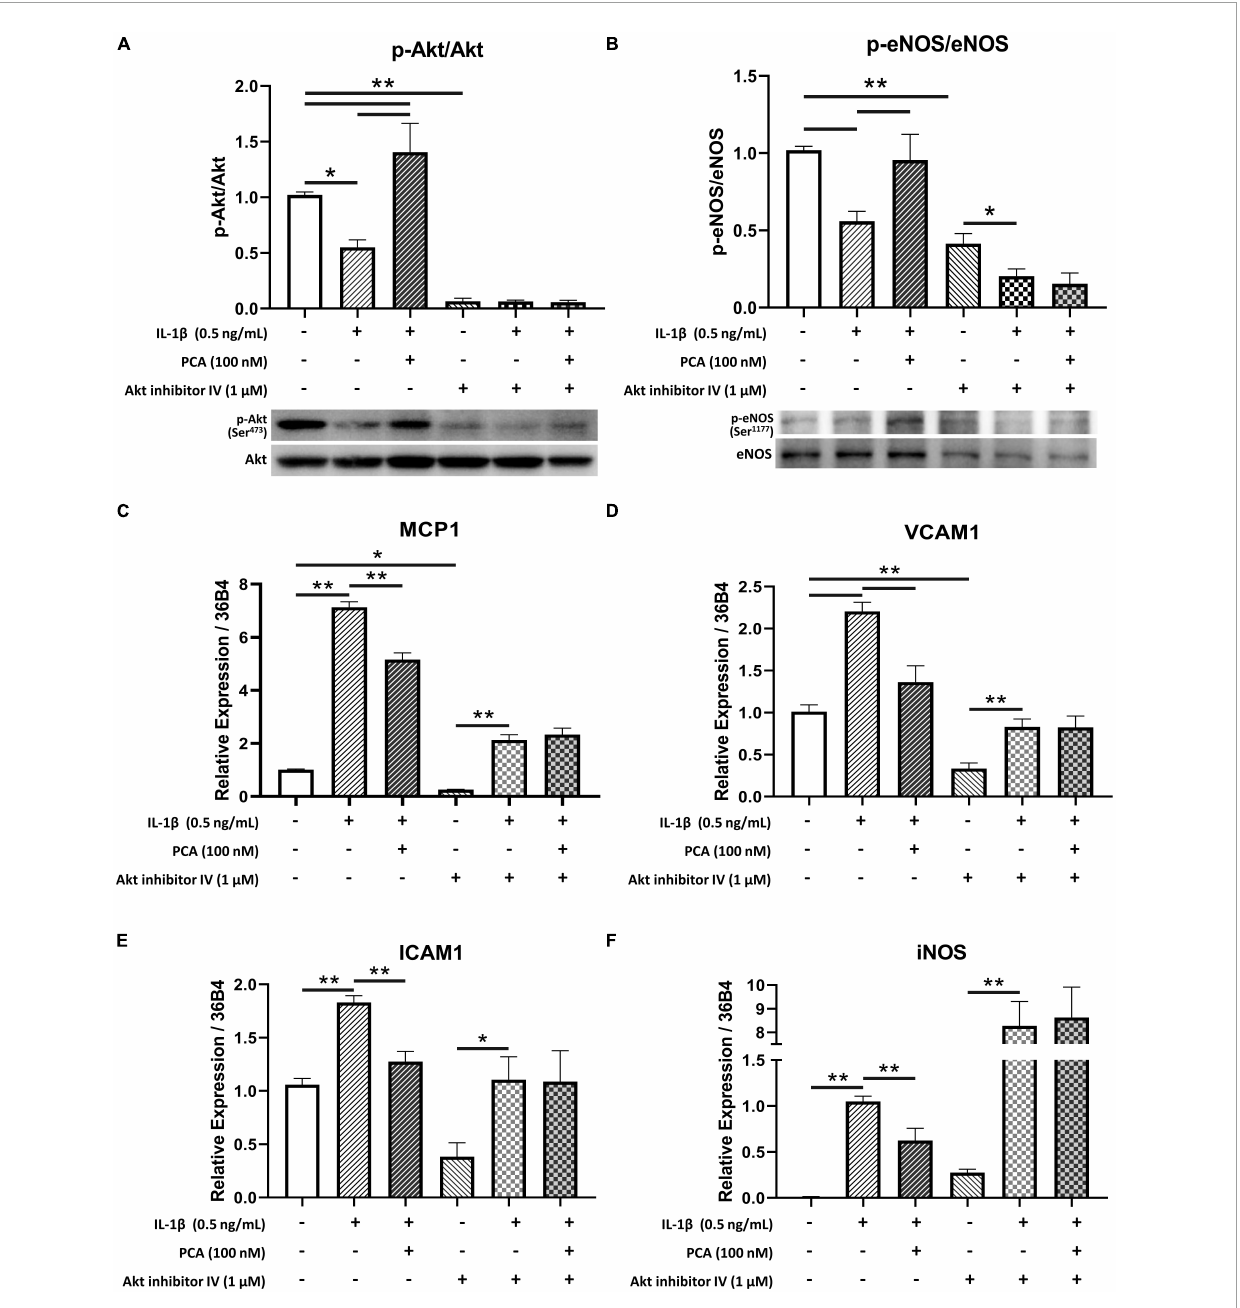
FIGURE5 Akt inhibitor IV hindered the restoration of p-eNOS/eNOS and suppression of pro-inflammatory cytokine expressions by PCA in IL-1 β -treated endothelial cells. Summarized protein quantification of (A) p-Akt/Akt and (B) p-eNOS/eNOS relative to GAPDH with and without IL-1 β (0.5 ng/mL), PCA (100 nM) and Akt inhibitor IV (1 µ M) incubation with representative immunoblots (D) ; n = 5. Summarized quantification of mRNA levels of MCP1 (C) , VCAM1 (D) , ICAM1 (E) , iNOS (F) relative to 36B4 in mBMECs with and without IL-1 β (0.5 ng/mL), PCA (100 nM) and Akt inhibitor IV (1 µ